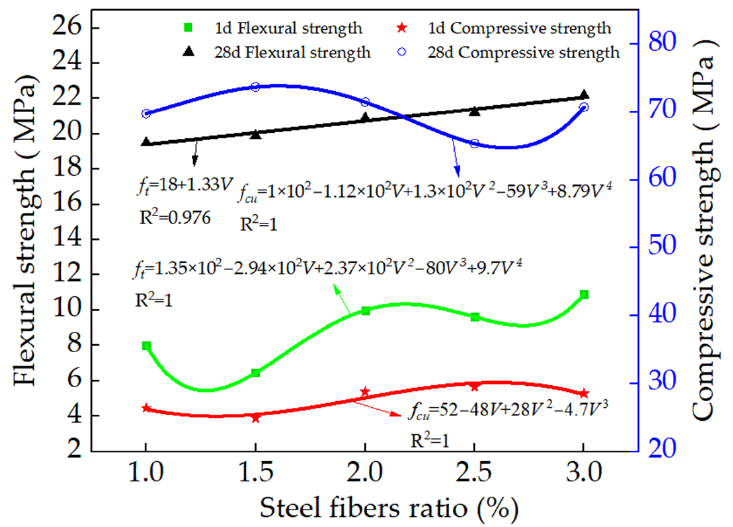
Figure 8. The relationship between flexural and compressive strengths and the volume of steel fibers.